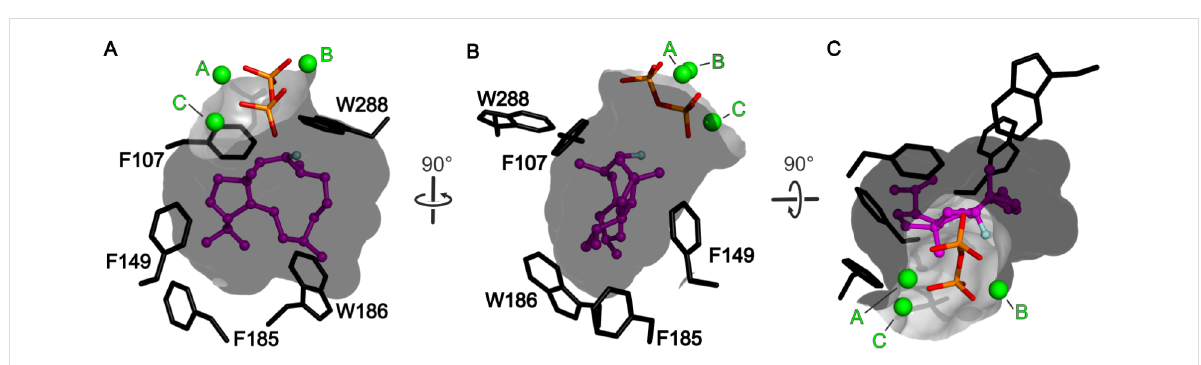
Figure 7: (A) The inner surface of the active site is shown in gray. The bound F-Dola reaction intermediate is shown in magenta with the fluorine atom colored in light blue. Aromatic residues are shown in black stick representation (B) View of panel A rotated by 90°. (C) View from the top into the active site of CotB2. View of panel A rotated by